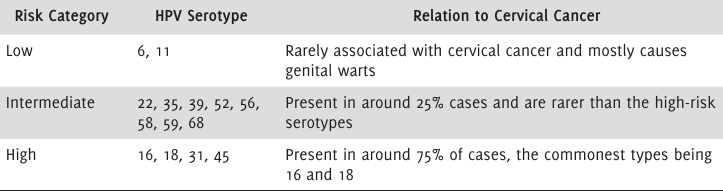
Table 1. HPV Serotypes Grouped according to Oncogenic Risk